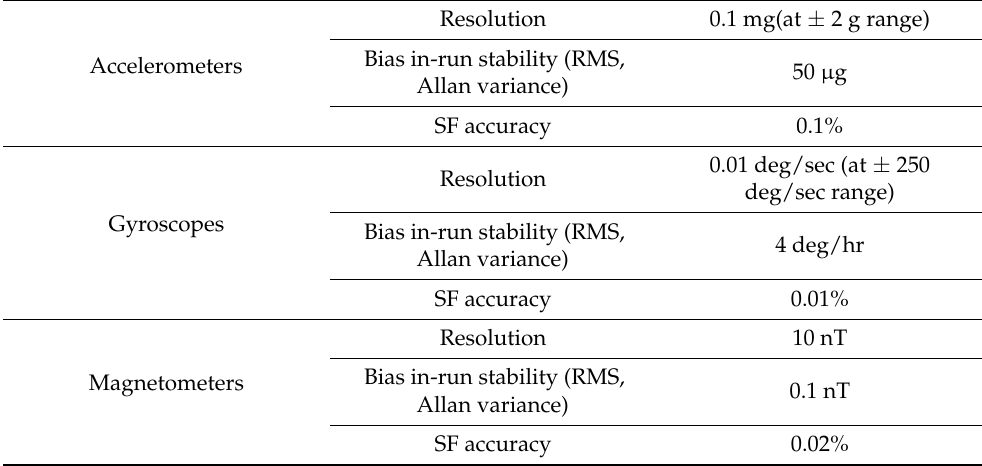
Table 2. The specifications for IMU.